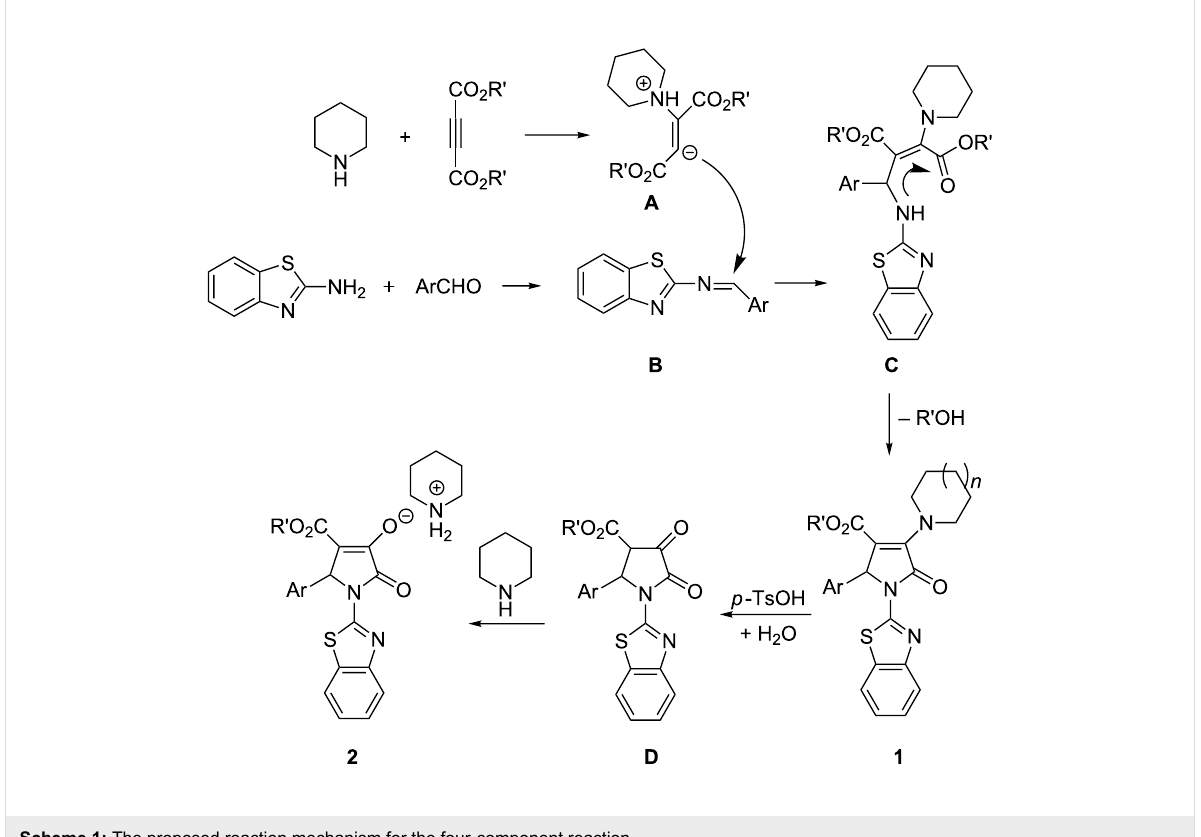
Scheme 1: The proposed reaction mechanism for the four-component